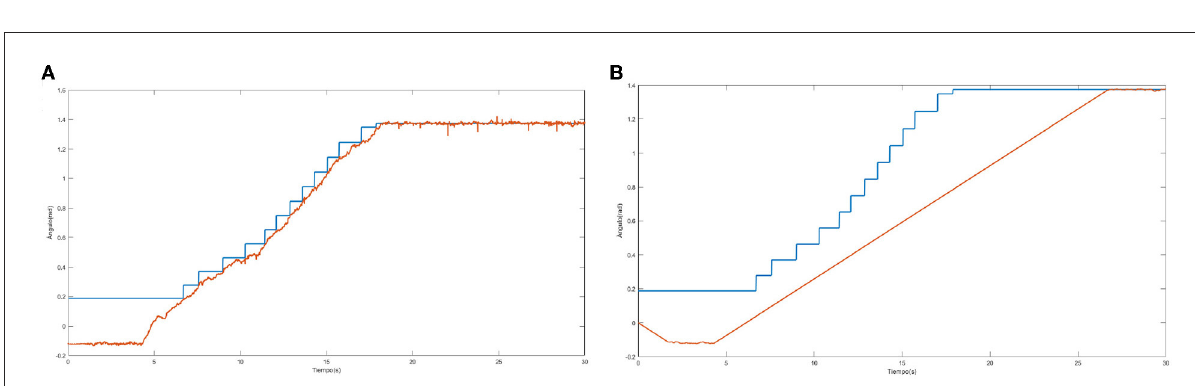
FIGURE15 Learning Path for Added Mass and Trajectory of the desired (blue) and actual (red) movement for Added Mass (B) . (A) Desired trajectory (blue) and output network